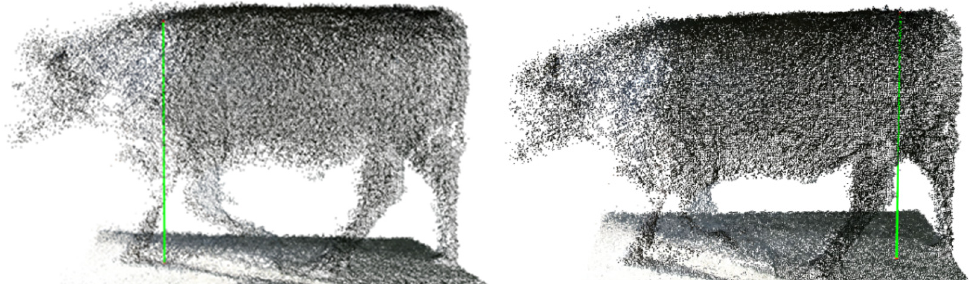
Figure 2. 3-D point cloud model of the cattle using the proposed system for 3-D reconstruction.